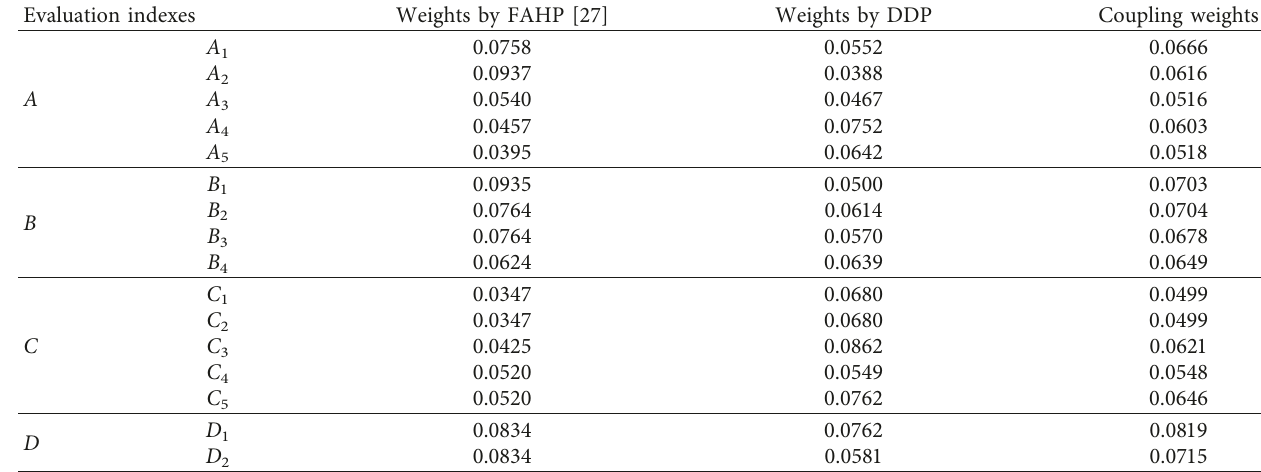
Table 4: FAHP-DDP coupling